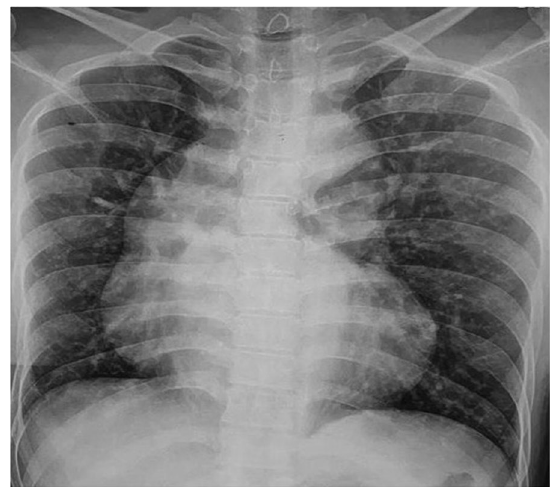
Fig. 1 Chest X ray-posteroanterior projection showing boot shaped heart and dilated aorta